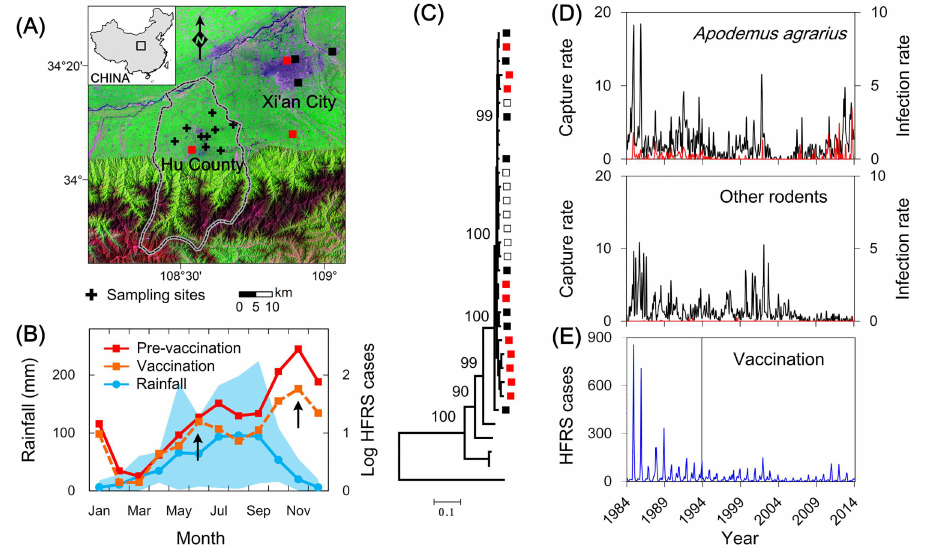
Fig 1. Hantavirus infections and host dynamics in Hu County of central China, 1984–2014. (A) Study area (108˚ E, 34˚ N) and samplingsites in Hu County on the Loess Plateau of central China. Crosses indicate rodent samplingsites, squaresrepresent locationsof sequencesobtainedfrom patients (black) and rodent lungs (red). (B) Mean numberof log-transformed reportedcases from 1984 to 2014, and the mean monthly rainfallover the same time period, indicating the two peaks of the rainy season (blue line). Monthly numberof HFRS cases duringthe pre-vaccination era (red line): 1984–1993, and vaccinationera (orangeline): 1994– 2014. Blue shadedregiongives ± 2 standarddeviationsof rainfall. Arrows indicatebimodalseasonal epidemics. (C) Phylogenetictree of HTNV in the study area. The black squaresrepresent the sequences obtained from patients, the red squaresrepresent the sequencesobtained from rodent lungs (1984–2012), and the hollow squaresrepresent the sequenceobtained in this study. (D) The monthly rodent capture rates (black line) and infection rates (red line). All capture rates are expressedas numberof rodents caught per 100 trap-nights, infection rates represent numberof captured rodent that carry hantavirus per 100 trap-nights. (E) Time series of HFRS cases in Hu County from 1984 to 2014,